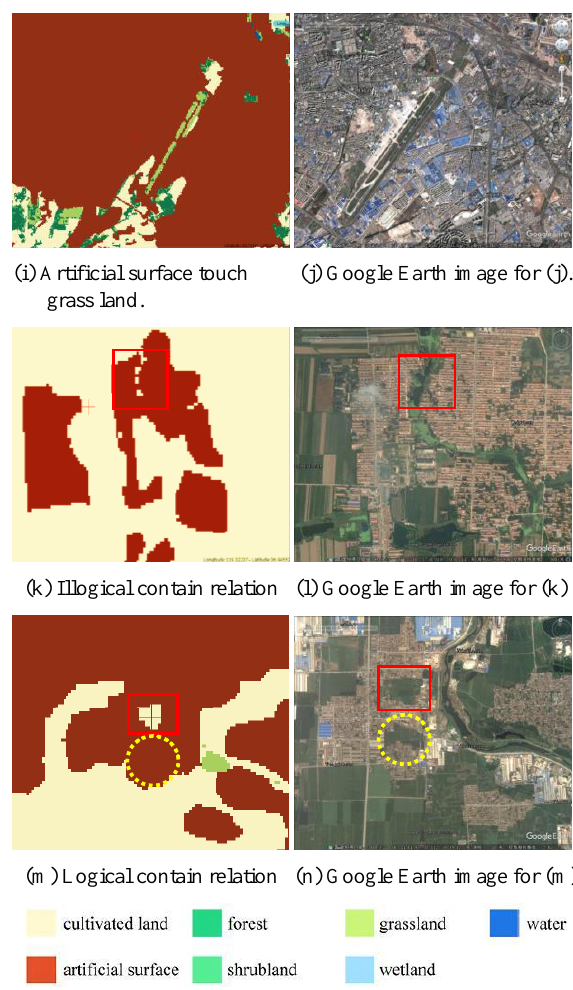
Figure 1. Topological relationships between land cover types.